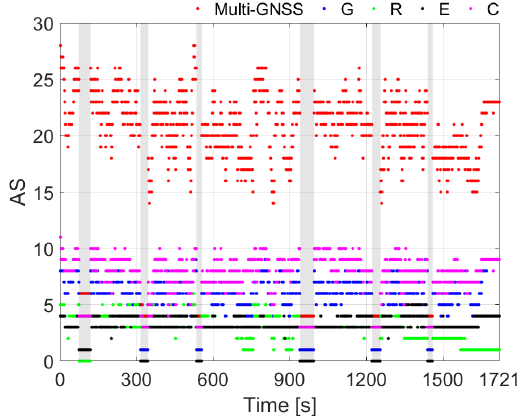
Figure 6. The AS number during the road experiments. Figure 7. Impacts of the LOS multipath and NLOS reception errors on the positioning solutions. Table 2. Three simulation schemes to analyze the impacts of the urban environment.